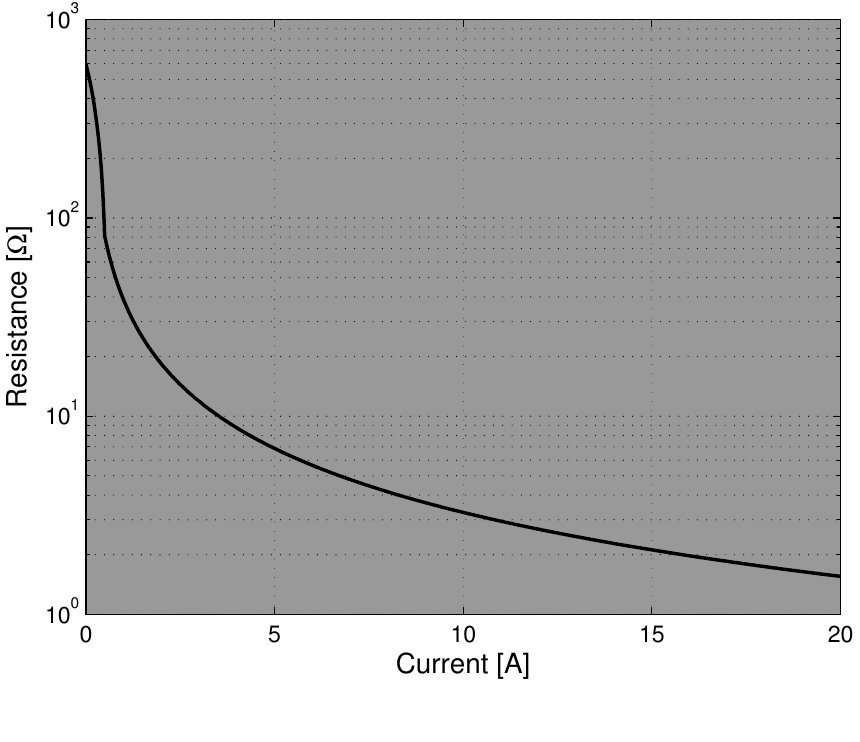
Figure 10. Characteristic curve of the electronic load in resistive